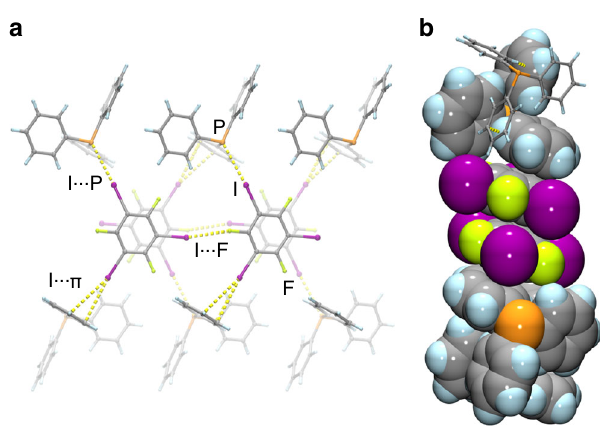
Fig. 2 Overview of molecular packing in the cocrystal ( tftib )( PPh 3 ). a Each of the iodine atoms of the per tftib molecule is involved in a short I···P interaction with a neighboring PPh 3 unit, an I··· π contact with another neighboring PPh 3 molecule or a short I···F contact to a neighboring tftib molecule. b Pairs of tftib molecules in the crystal structure stack with phenyl rings of two neighboring PPh 3 moieties. The cocrystal structures of ( tftib )( AsPh 3 ) and ( tftib )( SbPh 3 ) are isostructural and corresponding crystal structure views are shown in the Supplementary Fig.